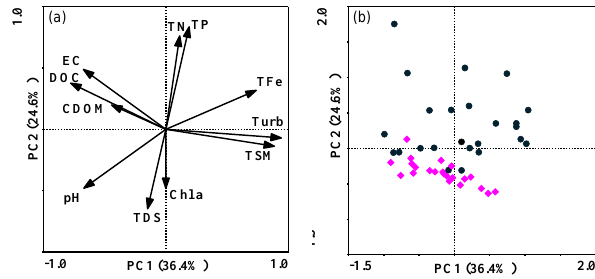
Figure 3. PCA of the physicochemical characteristics of all waters collected, (a) loading data of factors, and (b) sample scores. • rep- resents terminal lakes, and (cid:7) represents river